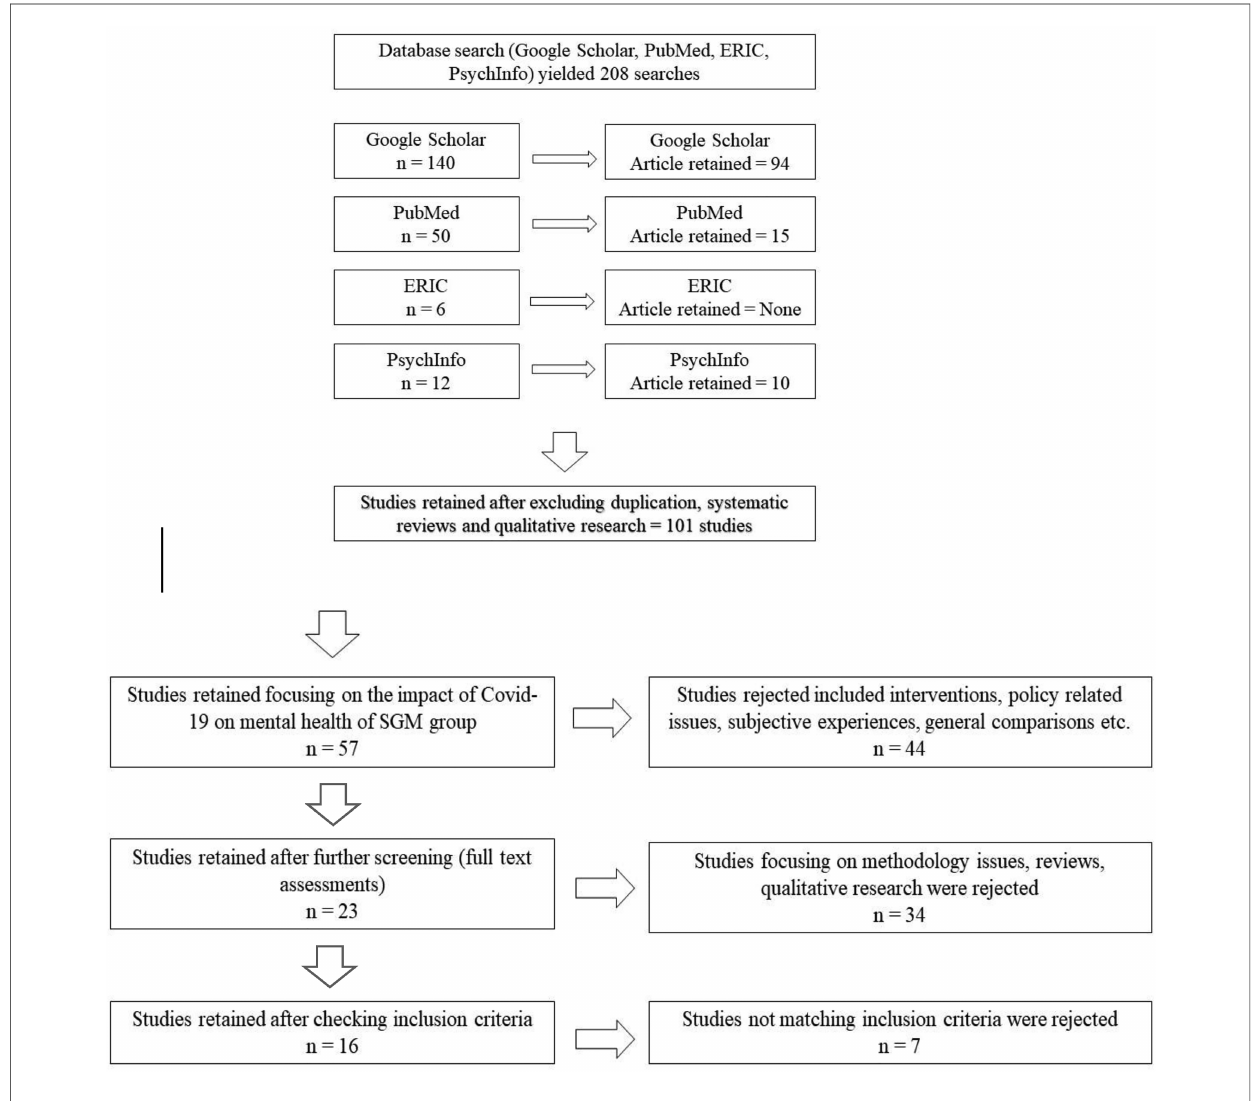
FIGURE 1 PRISMA framework representing the selection